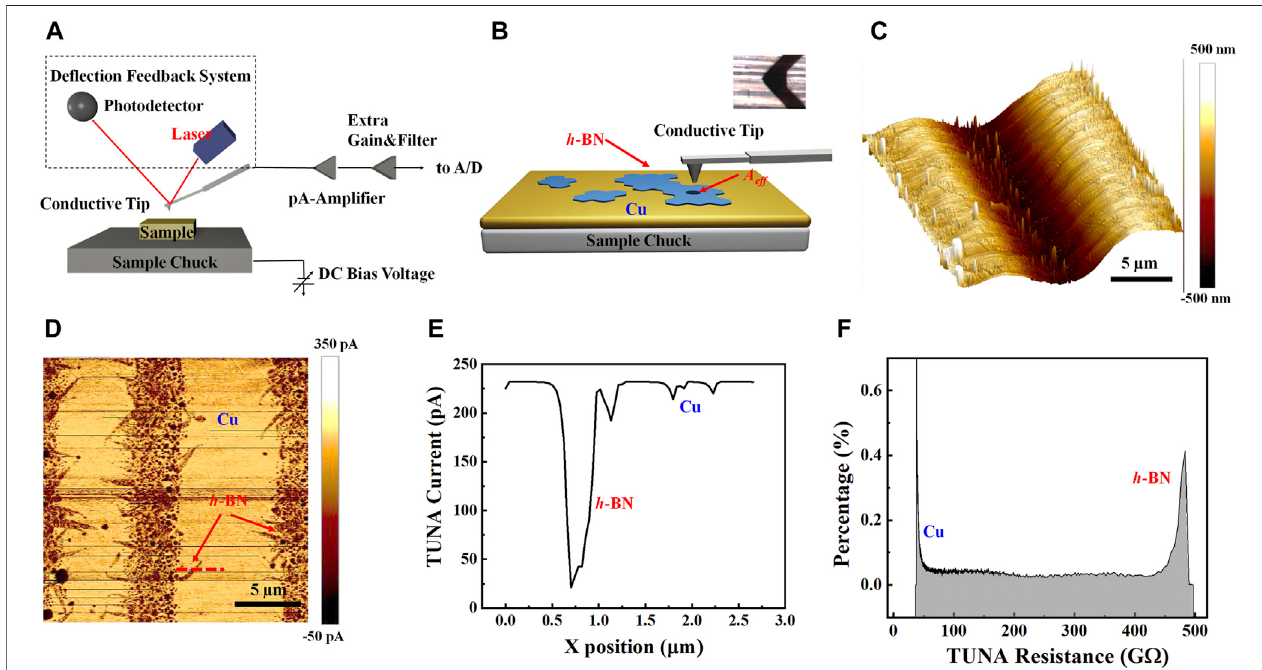
FIGURE 3 | AFM PF-TUNA measurements of monolayers h -BN nano fl akes on Cu. (A) Schematic of the working principle of AFM PF-TUNA mode. (B) Diagram of the measurement setup of TUNA current between the conductive AFM tip (inset) and monolayer h -BN on copper substrate. (C) AFM height image of as-grown monolayer h -BN on copper. (D) PF-TUNA current mapping of h -BN monolayer on copper. (E) A line pro fi le of the TUNA current taken from the red line in panel (D) . (F) The histogram distribution of the TUNA